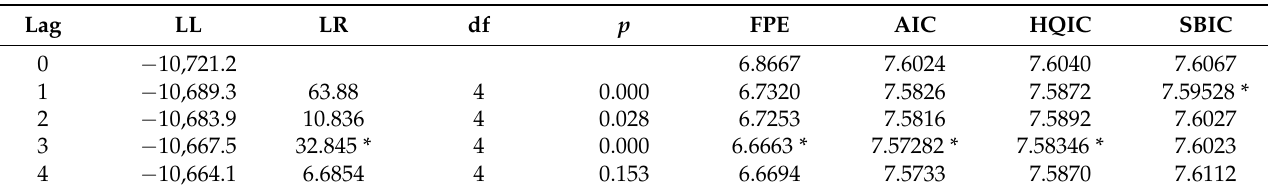
Table 4. Lag order test for WTI and CF .